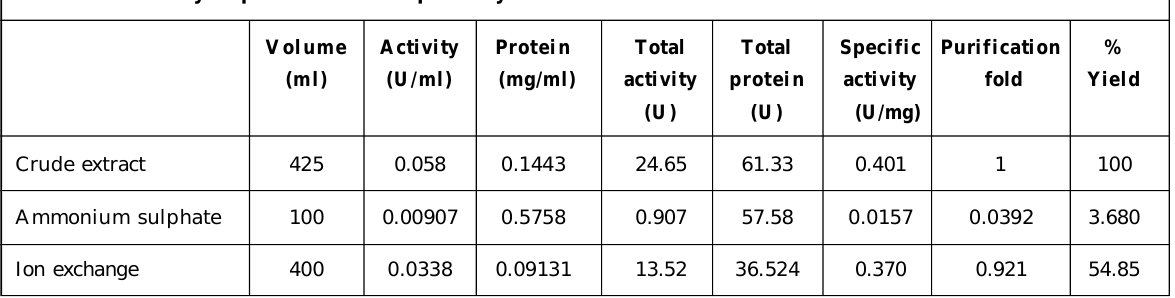
Table 6: Summary of purification of alpha